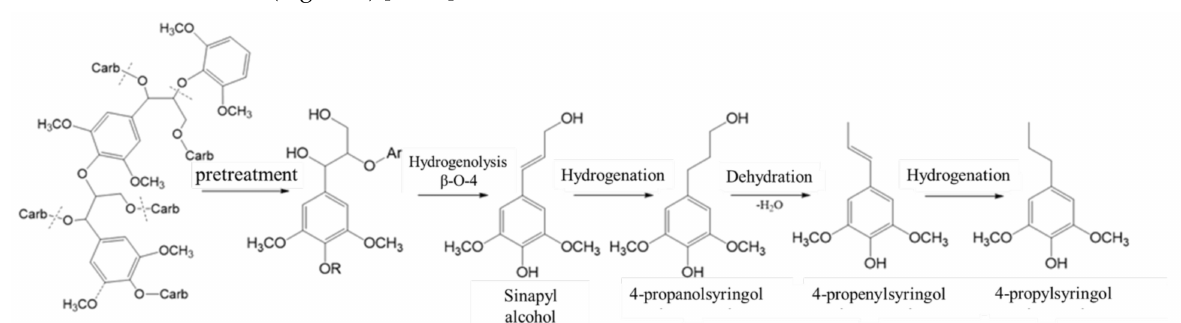
Figure 3. Formation of 4-Propylsyringol via cleavage of β -O-4 bonds followed by hydrogenation and dehydration of sinapyl alcohol.